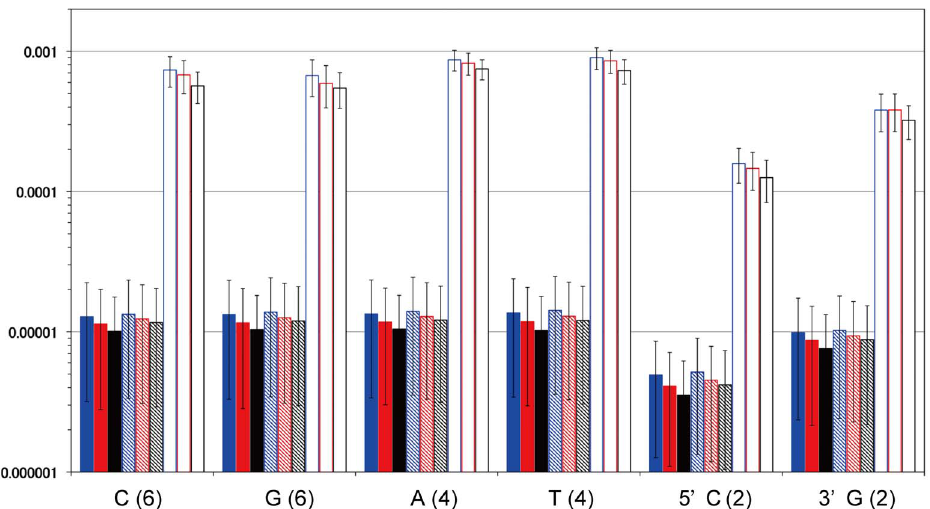
Figure 4. Relative contributions of each nucleotide to the electrostatic energy deviations, determined by the ZD and RESA methods from the Ewald electrostatic energy averaged for 1,000 sample structures produced by MD with the PME method (Eq. 10). The parameters for the individual bars are the same as those in Figure 3. The numbers in parentheses are the numbers of nucleotide types. The error bars are the standard deviations for 1,000 samples.